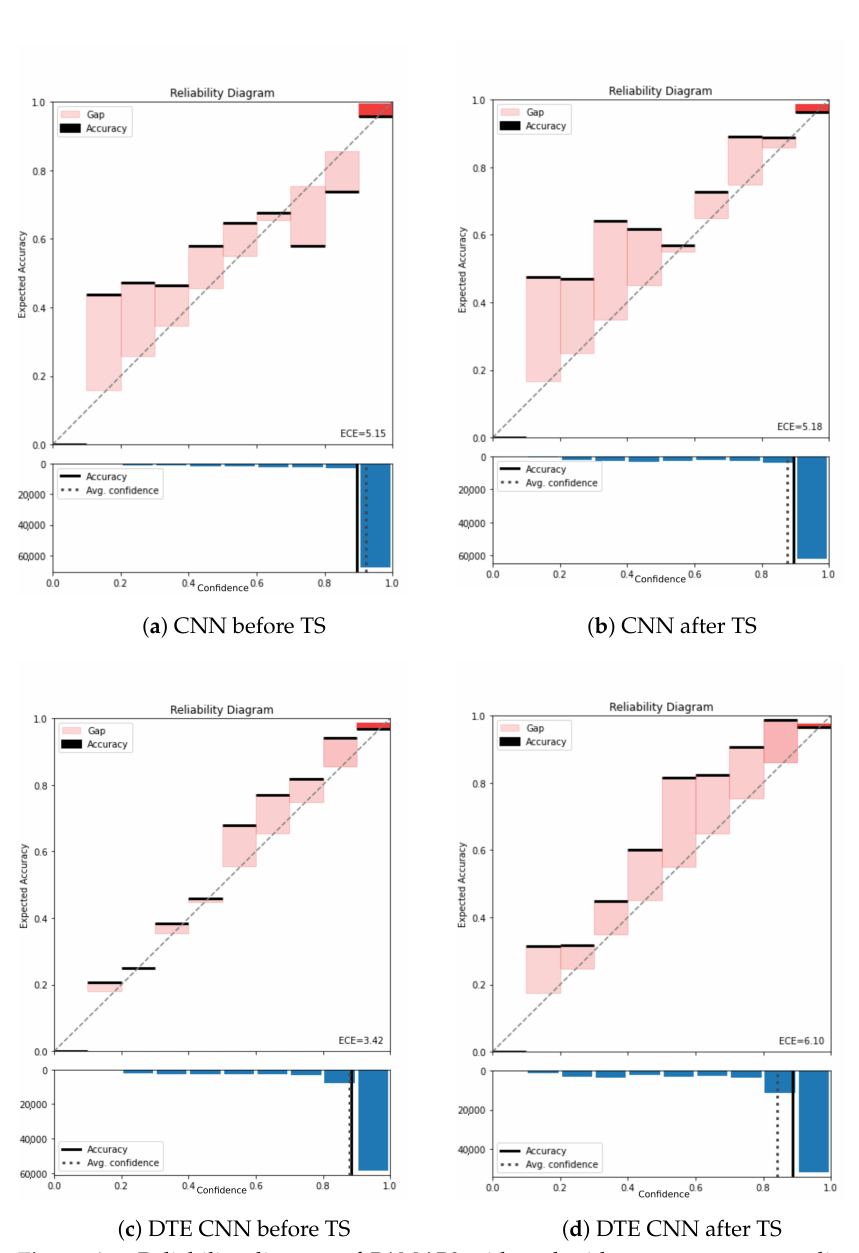
Figure A4. Reliability diagram of PAMAP2 with and without temperature scaling for CNN and DTE CNN